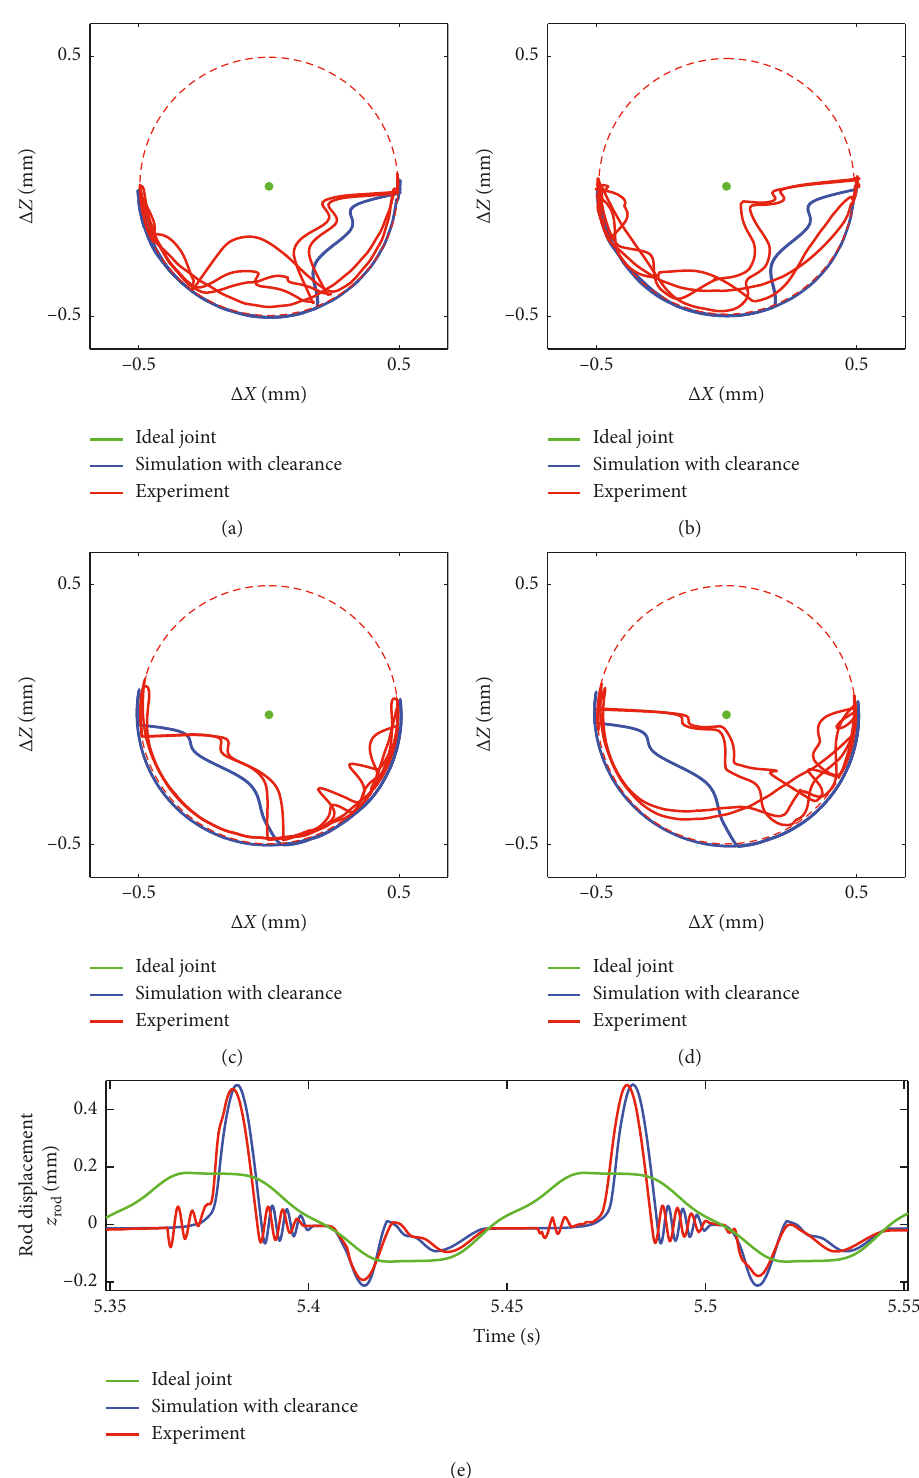
Figure 15: Trajectories and rod displacements in the numerical and experimental studies with c the right journal, (b) inside trajectories in the right journal, (c) outside trajectories in the left journal, (d) inside trajectories in the left journal, and (e) displacement z rod of the